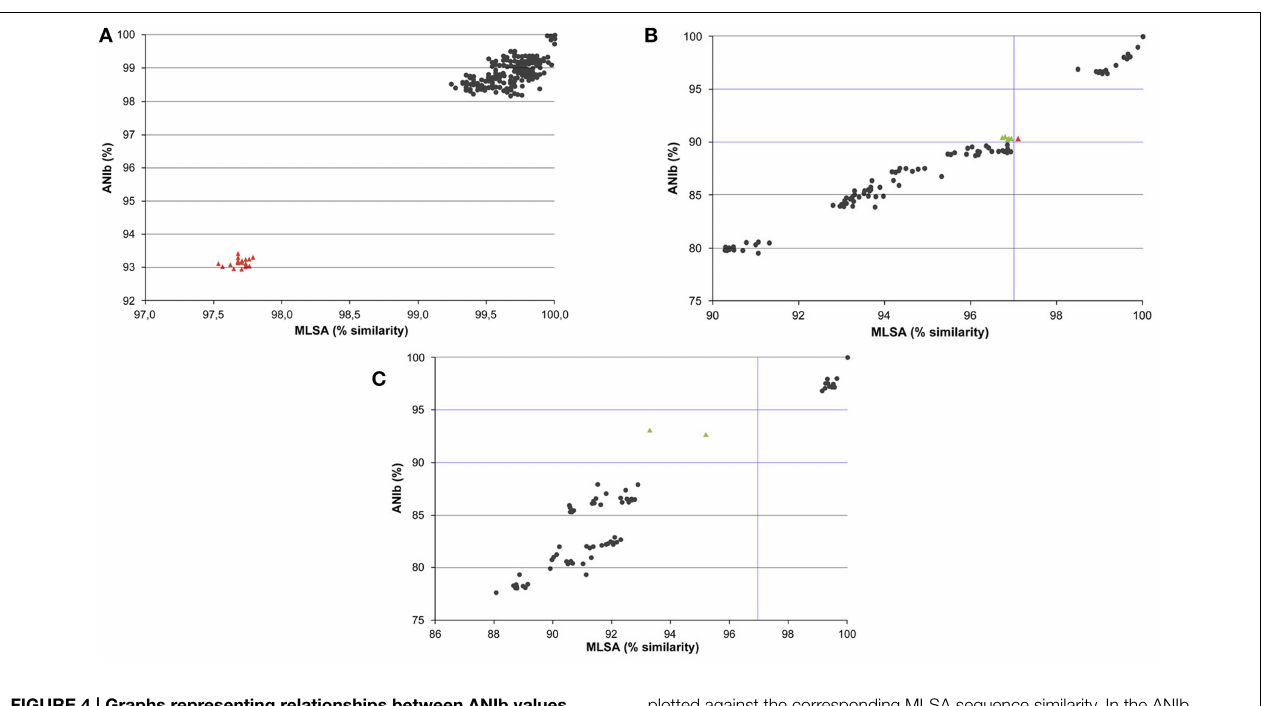
plotted against the corresponding MLSA sequence similarity. In the ANIb range of 90–95%, green triangles indicate pairwise comparisons with MLSA values lower than 97% and red triangles values between 97 and 98%; other values are indicated with black